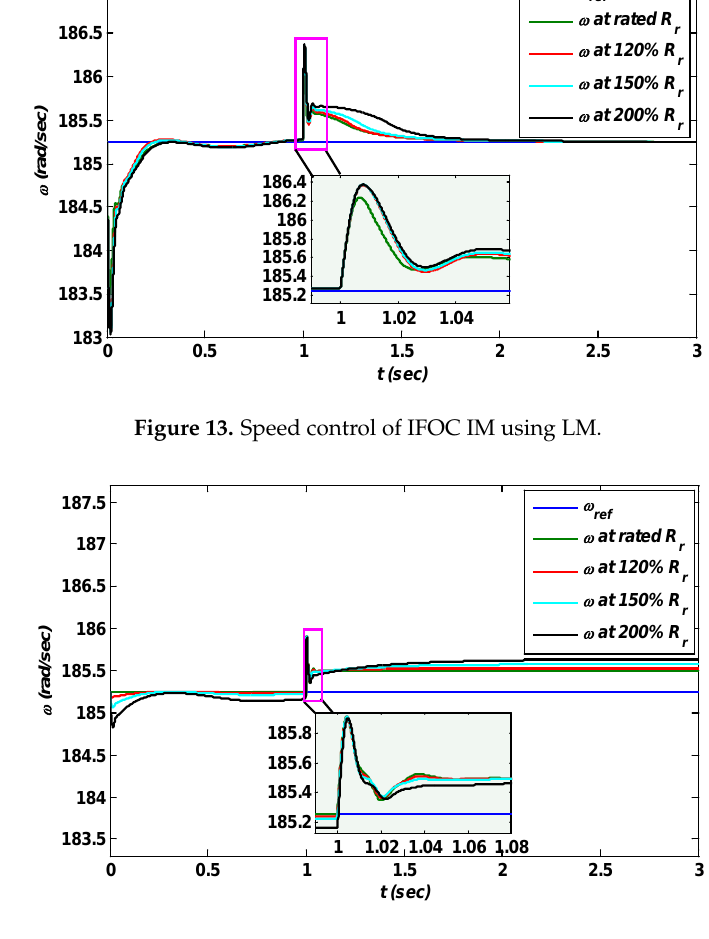
Figure 15. Speed control of IFOC IM using Sliding Mode Control (SMC).